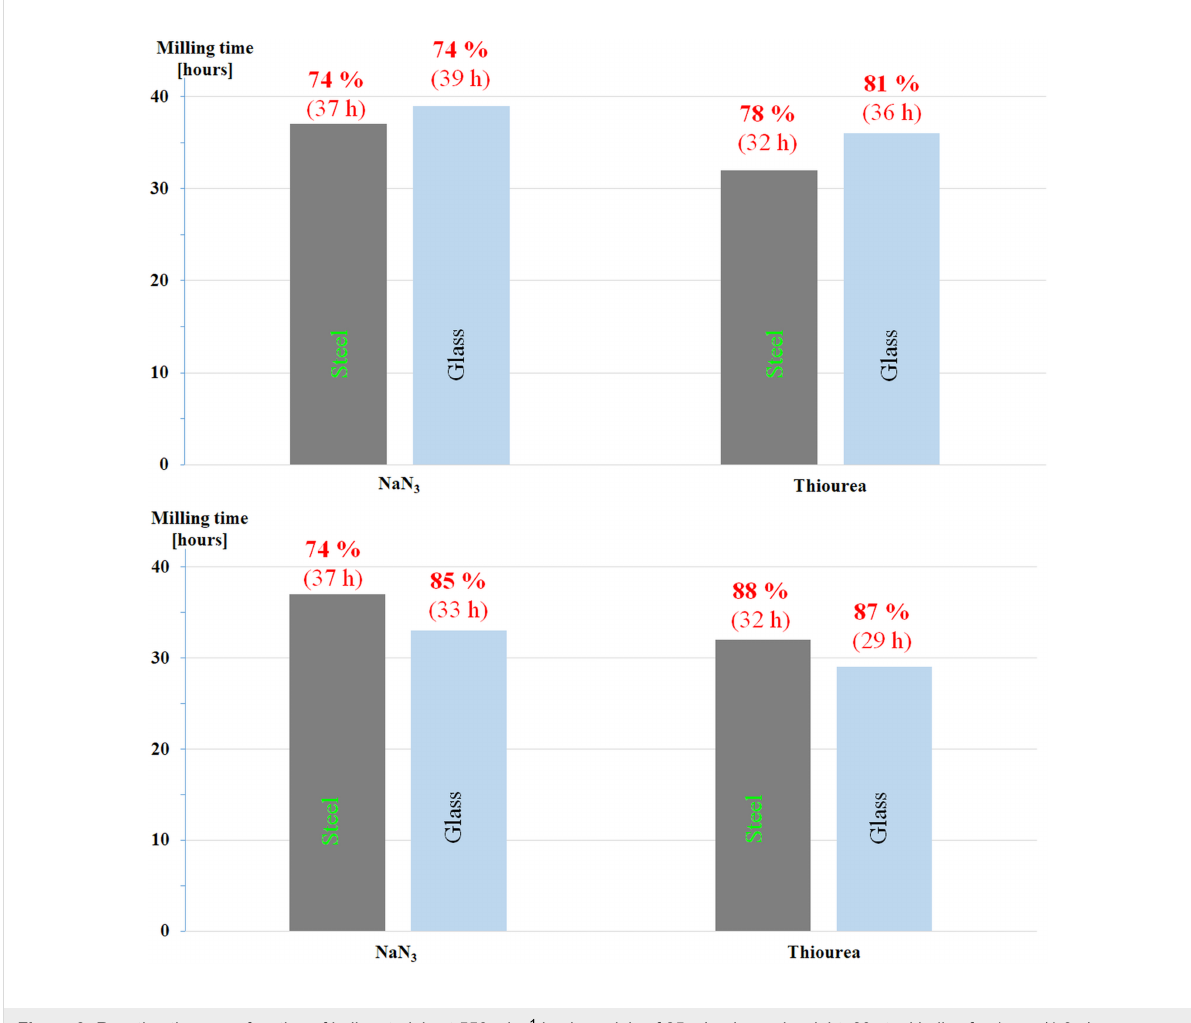
Figure 3: Reaction time as a function of ball materials at 550 min − 1 in glass vials of 25 mL: a) equal weight: 60 steel balls of ø 1 mm (1.8 g) vs . 20 glass balls of ø 3 mm (1.8 g); b) 60 steel balls of ø 1 mm ( m B = 1.8 g, m B / m R ca. 12, Φ MB,packing = 0.003) vs. 60 glass balls of ø 3 mm ( m B = 5.4 g, m B / m R ca. 35, Φ MB,packing = 0.077). Values given on the graphic bars indicate, respectively, the yield and the reaction time to achieve full conversion of the starting Ts- β